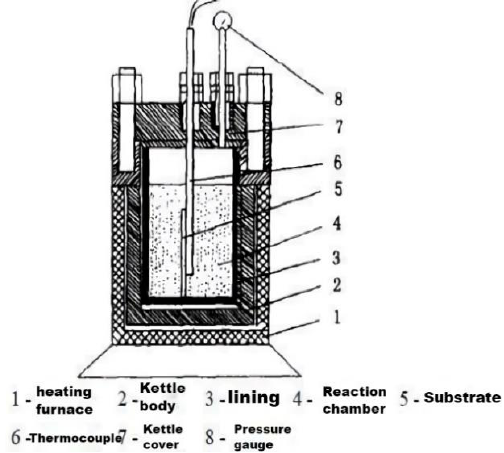
Figure 8. Hydrothermal reactor.